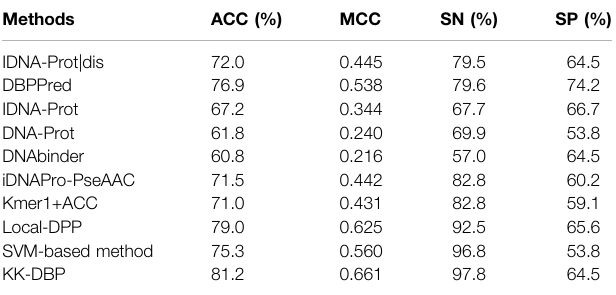
TABLE 2 | Performance of this method and other existing methods on PDB186.